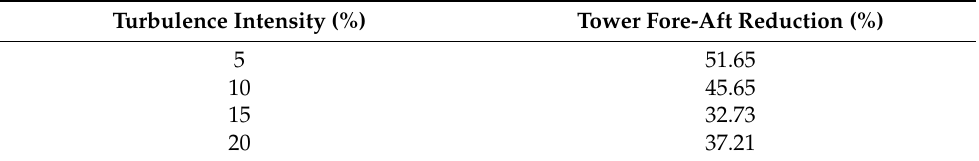
Figure 21. TMD performance in reducing tower fore-aft vibration. ( a ) TMD stroke. ( b ) fore-aft vibration of the tower with and without TMD. Table 5. The reduction rate of fore-aft vibration in constant mean wind speed of 20 m/s and different turbulence intensities.